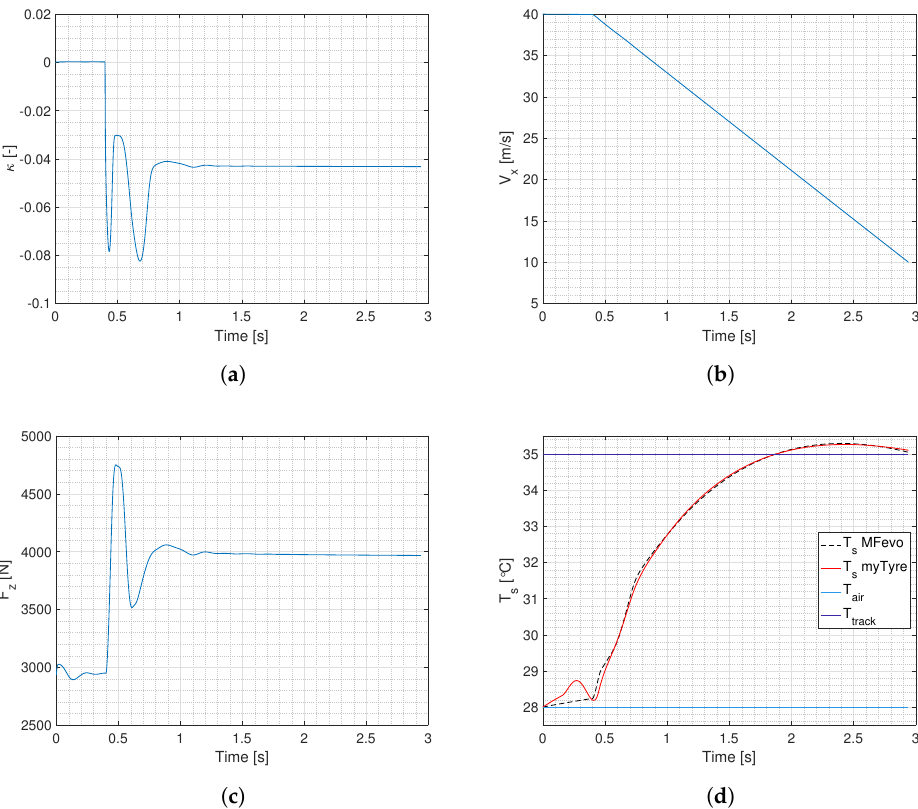
Figure 9. myTyre thermal model validation. ( a ) Longitudinal slip input; ( b ) Longitudinal velocity in- put; ( c ) Tyre normal load input; ( d ) Tread surface temperature output.